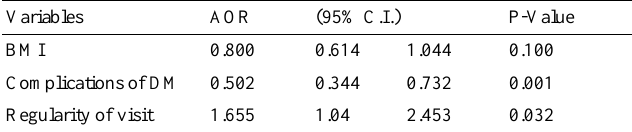
Binary logistic regression for Mental Component score with significant study variables.